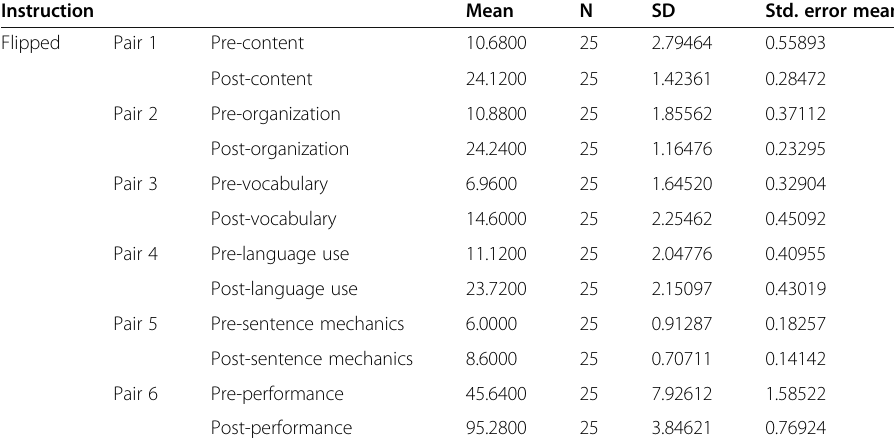
Table 1 Paired sample descriptive statistics